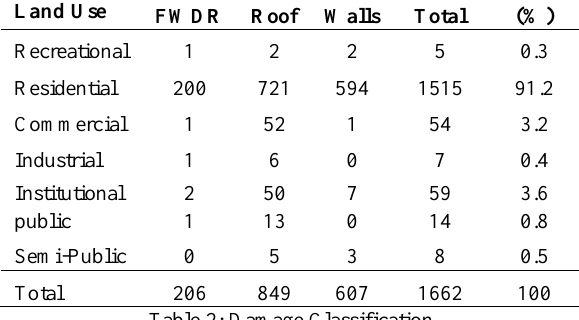
Table 2: Damage Classification